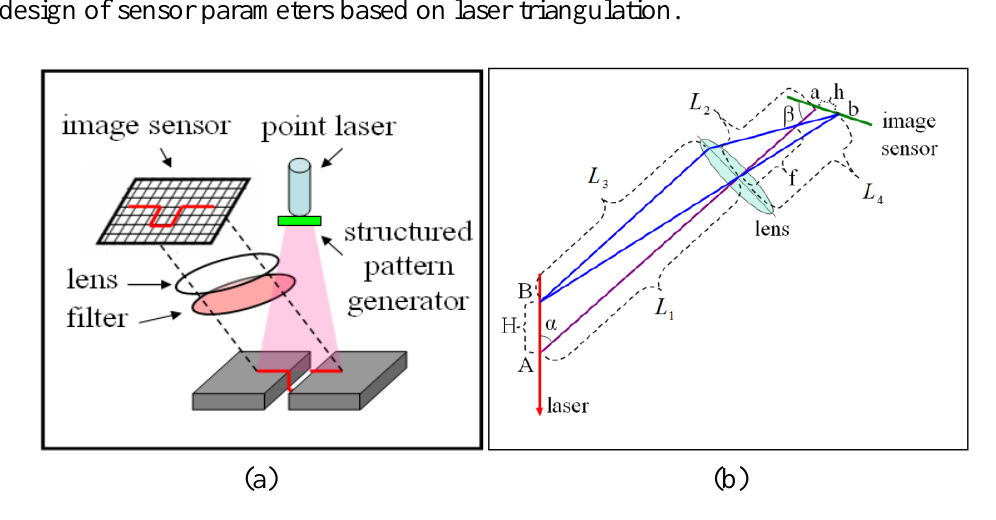
Figure 1. Design principle of the laser-based vision sensor: (a) schematic of the sensor and (b) design of sensor parameters based on laser